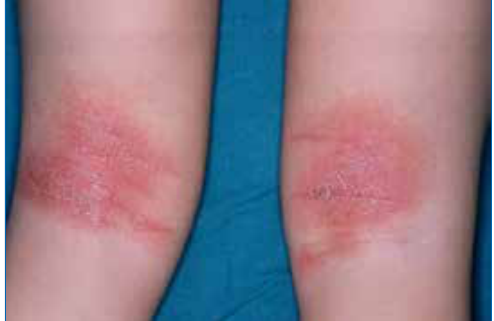
Figure 1. Atopic dermatitis – flexural areas 5